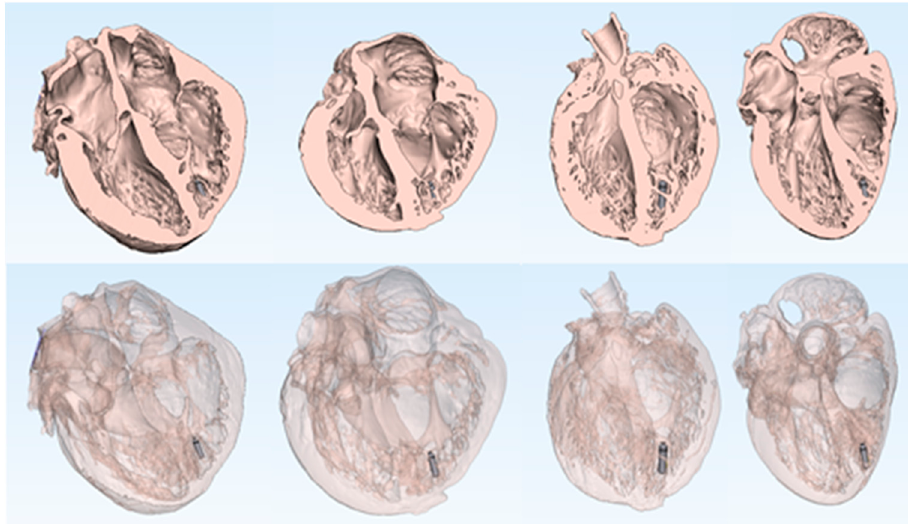
Figure 4. Anterior views of sliced human hearts depicting Micra TM transcatheter pacing system computationally implanted into each right ventricle (left to right: HH229, HH248, HH102, and HH311). Each heart model is depicted with no transparency (top) and high transparency (bottom).